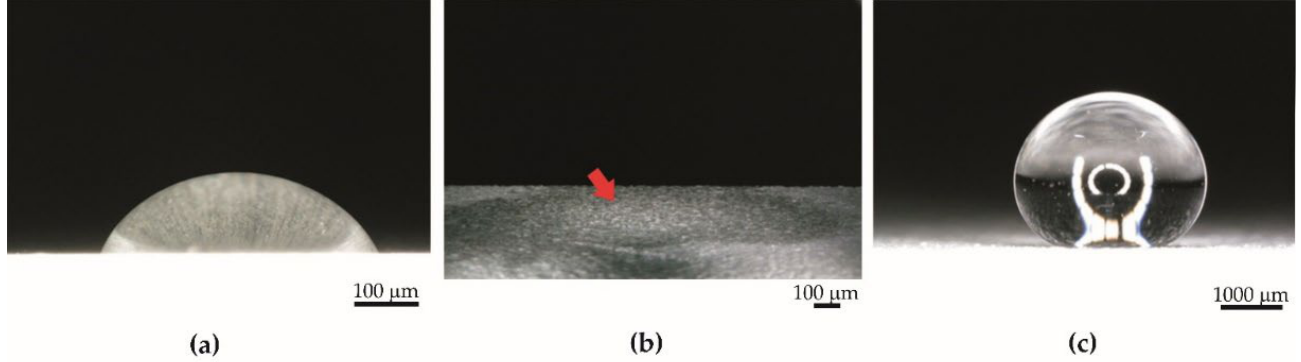
Figure 3. A drop of water on ( a ) hydrophilic surface (specimen from Series 1), ( b ) superhydrophilic surface (specimen from Series 2 before impregnation), ( c ) superhydrophobic surface (specimen from Series 2 after impregnation).